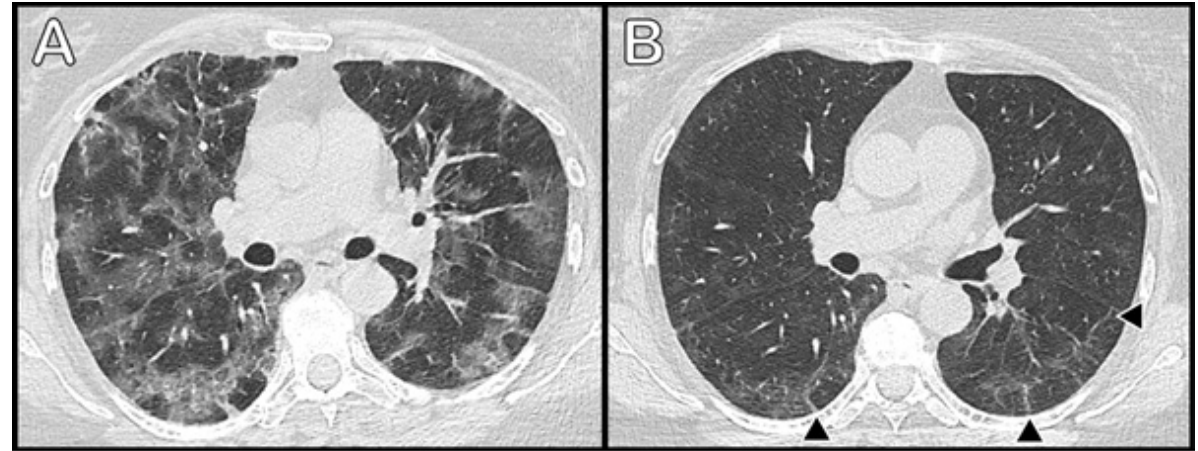
Figure 2. Axial thin-section chest CT images of a 60-year-old woman with confirmed COVID-19 pneumonia. ( A ) CT scan 10 days after the onset of symptoms at the peak stage of the disease. Multiple coalescing ground-glass opacities are seen in both lungs, with thickening of the interlobular septa in the lung periphery. ( B ) Follow up scan after 2 months. A decrease in density and size of ground-glass opacities can be seen, with persisting thickening of the interlobular septa and some parenchymal bands (black arrowheads) in peripheral parts of lungs.